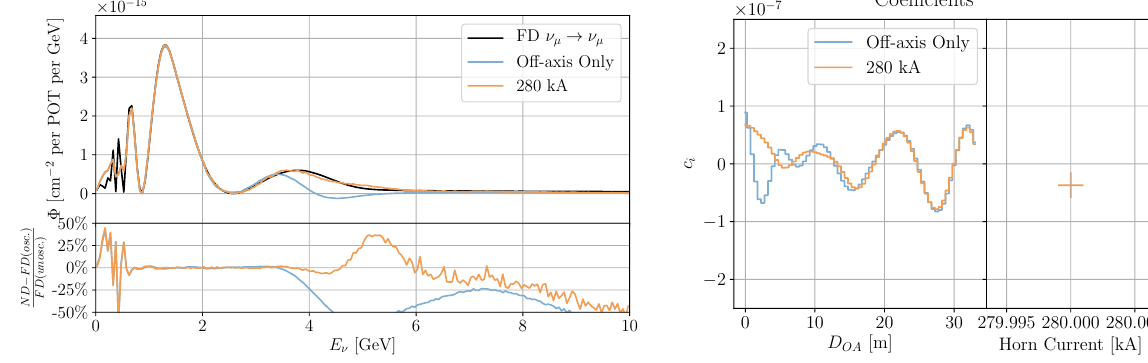
Figure 105. The FD flux and the ND linear combination flux match ( left ) and corresponding coefficients ( right ) are shown utilizing an additional horn current flux. The result is a method that provides good flux matching over multiple sets of oscilla- tion parameters, as shown in Figure 106.